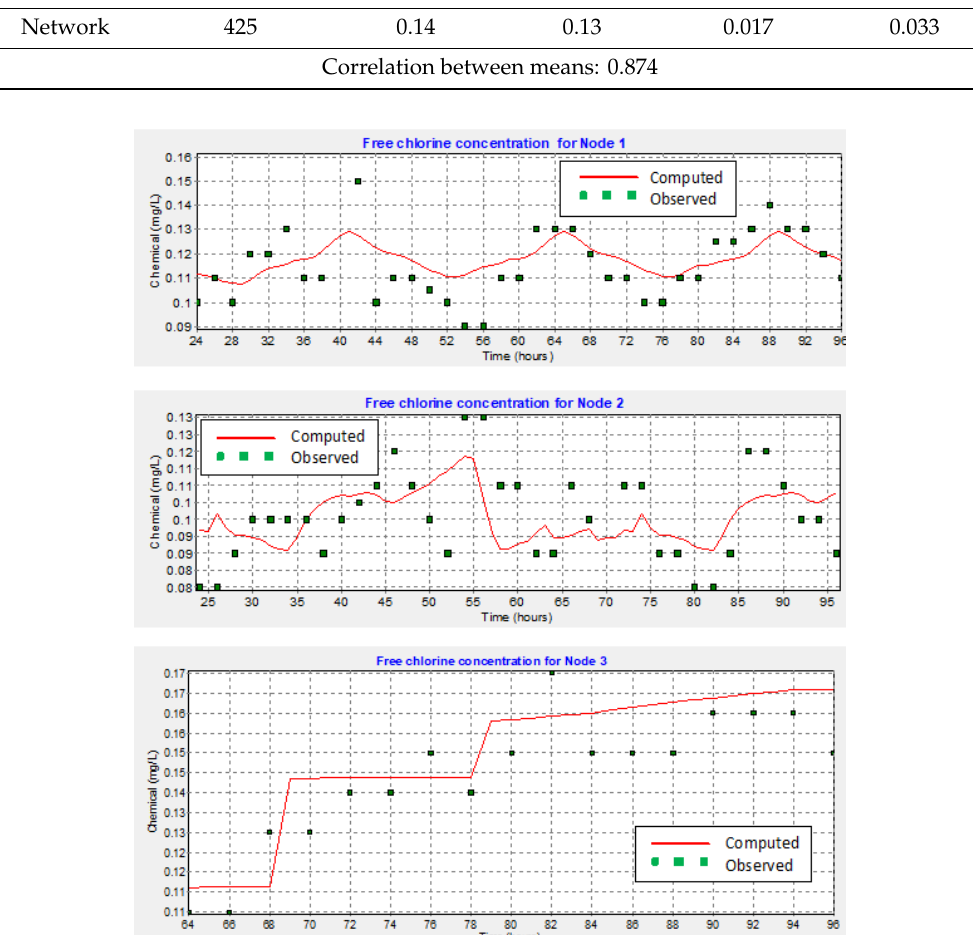
Figure 3. Exemplary graphs showing the results of field studies and simulations following the calibration process—Node 1 at the top, Node 2 in the middle, and Node 3 at the bottom. The numbers of measurement points are in accordance with Figure 2 .